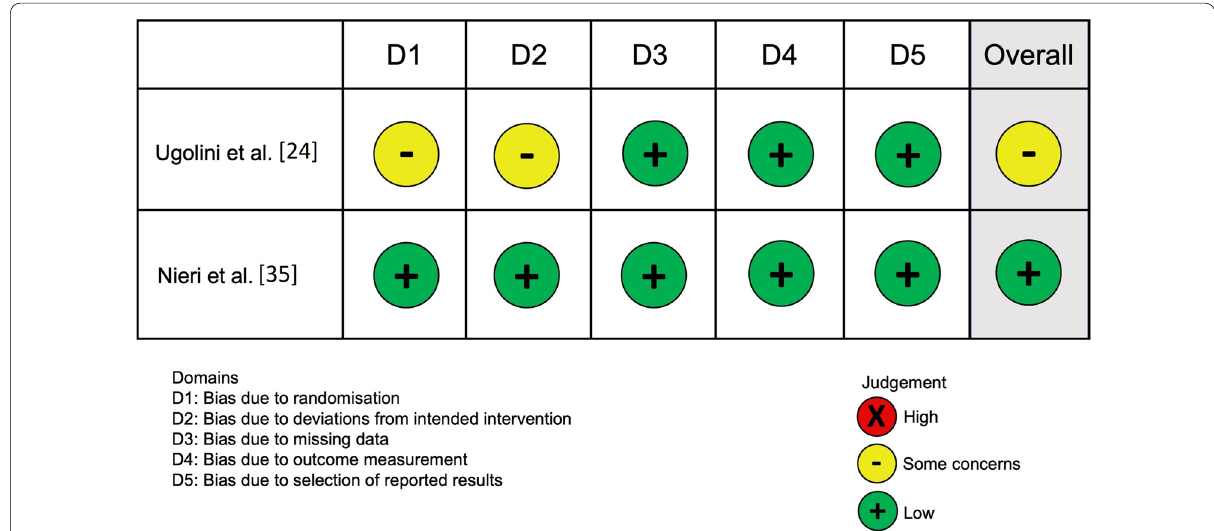
Fig. 2 Risk of bias of included